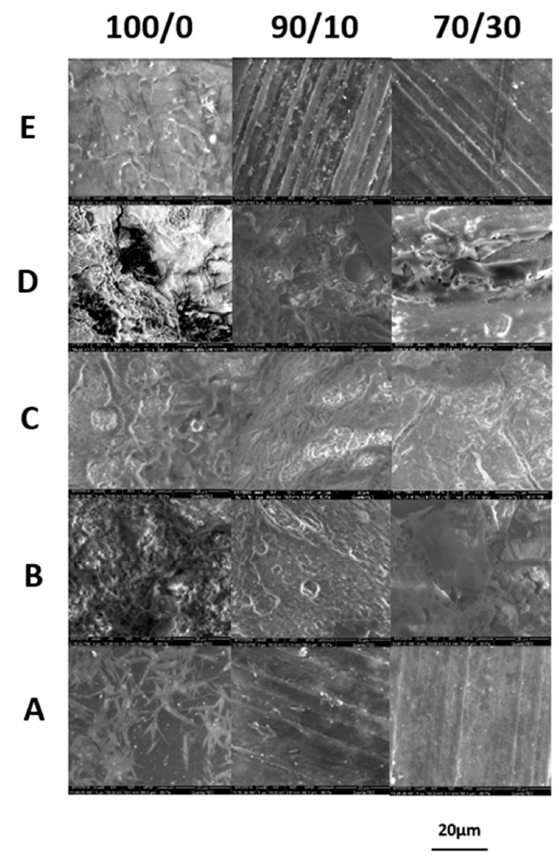
Figure 4. SEM micrographs (5000x) of the pure P(3HB -co- 4HB) (100/0) and P(3HB -co- 4HB)/cork composites with a mass ratio of 90/10 and 70/30, respectively, before ( A ) and after 21 days of degradation in a respirometer ( B ), BIODEGMA ( C ), container ( D ) and water ( E ).